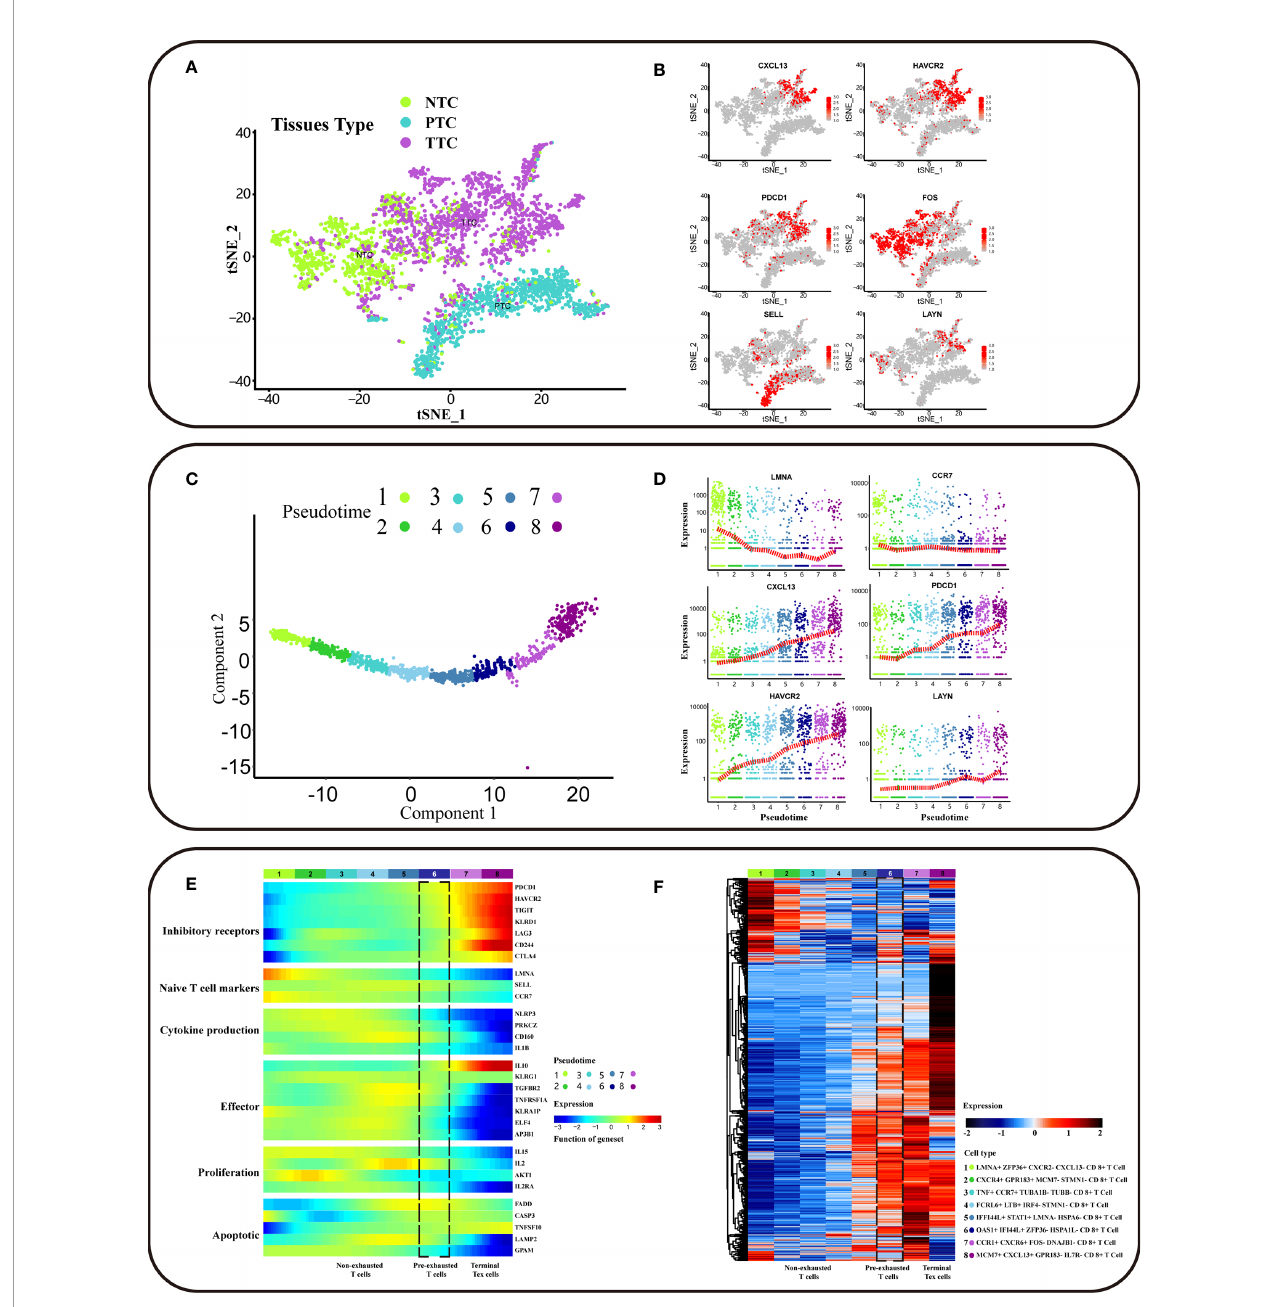
FIGURE 2 | Trajectory of differentiation pro fi les of CD8 + T cells. (A) t-SNE clustering of T cells (n = 3628) from scRNA-seq of CRC patients showing three clusters (n = 3). Bright green dots for NTC (CD8 + T cells from adjacent normal colorectal tissues), blue-green dots for PTC (CD8 + T cells from peripheral blood), purple dots for TTC (CD8 + T cells from tumor). (B) The gene expression of HAVCR2, CXCL13, PDCD1, FOS, SELL , and LAYN in the scRNA-seq landscape. Low to high gene expression is indicated by a gradation from grey to red. The cell subpopulations with high gene expression correspond to sources referenced to the location of the NTC, PTC, and TTC clusters in (A) . (C) Potential developmental trajectory of CD8 + T cells in tumor tissues (n = 1646) inferred by Monocle2 based on gene expression. Pseudotime is shown numbered from 1 to 8, and the start of pseudotime is indicated. (D) The expression levels of LAYN , CXCL13, CCR7, LMNA, PDCD1 and HAVCR2 in different pseudotime of CD8 + T cell subpopulation. The x-axis represents pseudotime, and the y-axis represents gene expression. The red dash indicates the average gene expression. (E) The heatmap showing the dynamic expression changes of genes, including the function of T cell cytokine production, T cell apoptotic process, inhibitory receptors, cell proliferation, regulators associated with T cell exhaustion and T cell effector function. (F) The heatmap showing cell type-speci fi c gene marker expression in the different T cell clusters. The marker genes for each cluster as determined by Seurat analysis with four selected genes per cluster highlighted on the